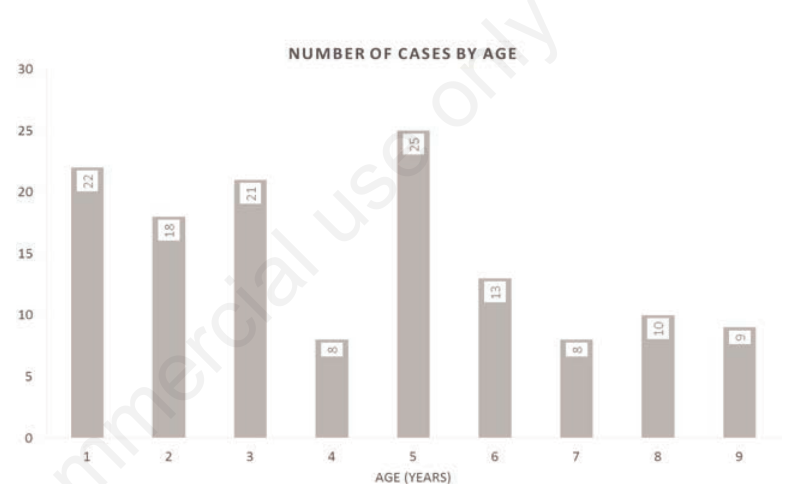
Figure 1. Number of cases by age.